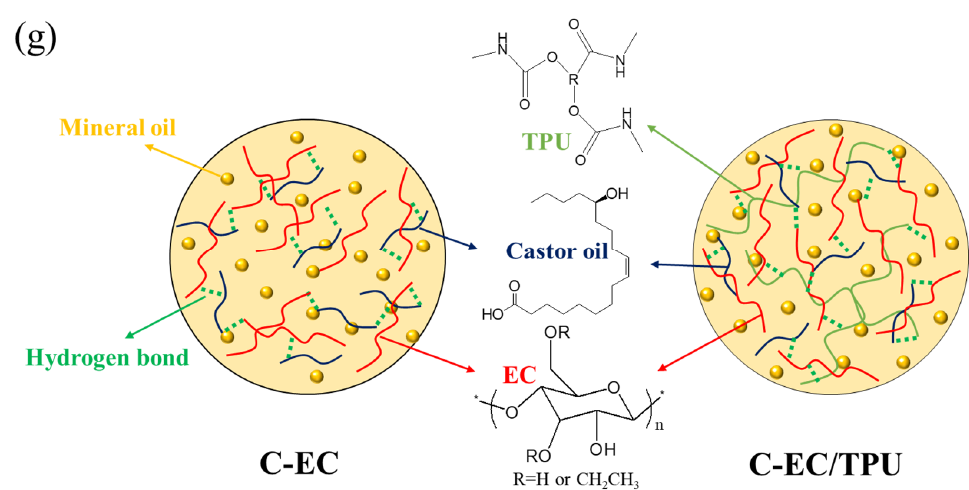
Figure 4. SEM images of ( a ) the surface of C-EC coating, ( b ) the cross-section of C-EC coating, ( c ) the surface of C-EC/TPU coating, ( d ) the cross-section of C-EC/TPU coating, ( e ) the "groove" scale profiles in Figure 4b, ( f ) the “groove” scale profiles in Figure 4d, ( g ) The C-EC and C-EC / TPU materials model the diagram.